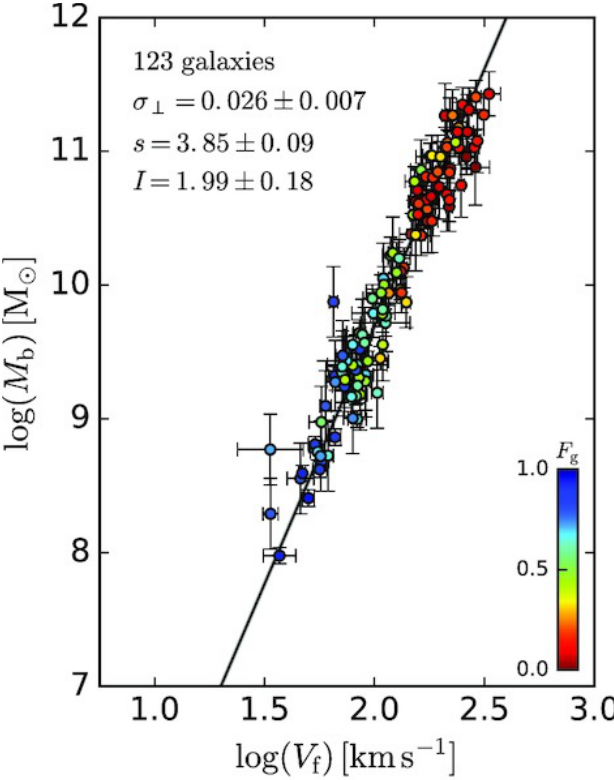
Figure 1. The baryonic Tully–Fisher relation (BTFR) built for a subsample of 123 galaxies from the SPARC catalogue [51]. M b is the total galaxy baryonic mass, accounting for the stars and the gas, and V f is the mean circular velocity along the flat region of the rotation curve. The black solid line represents the linear fit to the data with the relation log ( M b /M (cid:12) ) = s log ( V f /km s − 1 ) + I . σ ⊥ denotes the intrinsic scatter of the BTFR, expressed in dex. The galaxies are colour-coded according to the gas fraction F g to the total baryonic mass. The figure is re-adapted from Figure 2 in